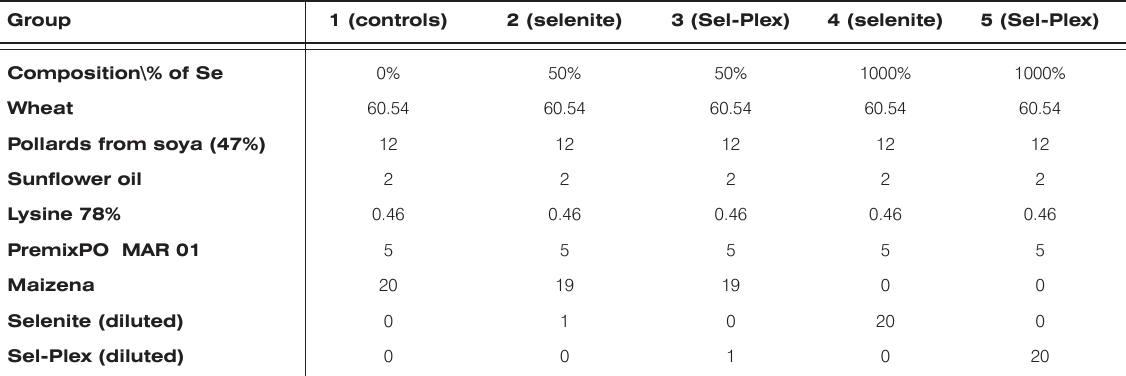
Table 1. Composition of feed expressed in %, where one percent means 0.075 mg of feed per kg of the experimental